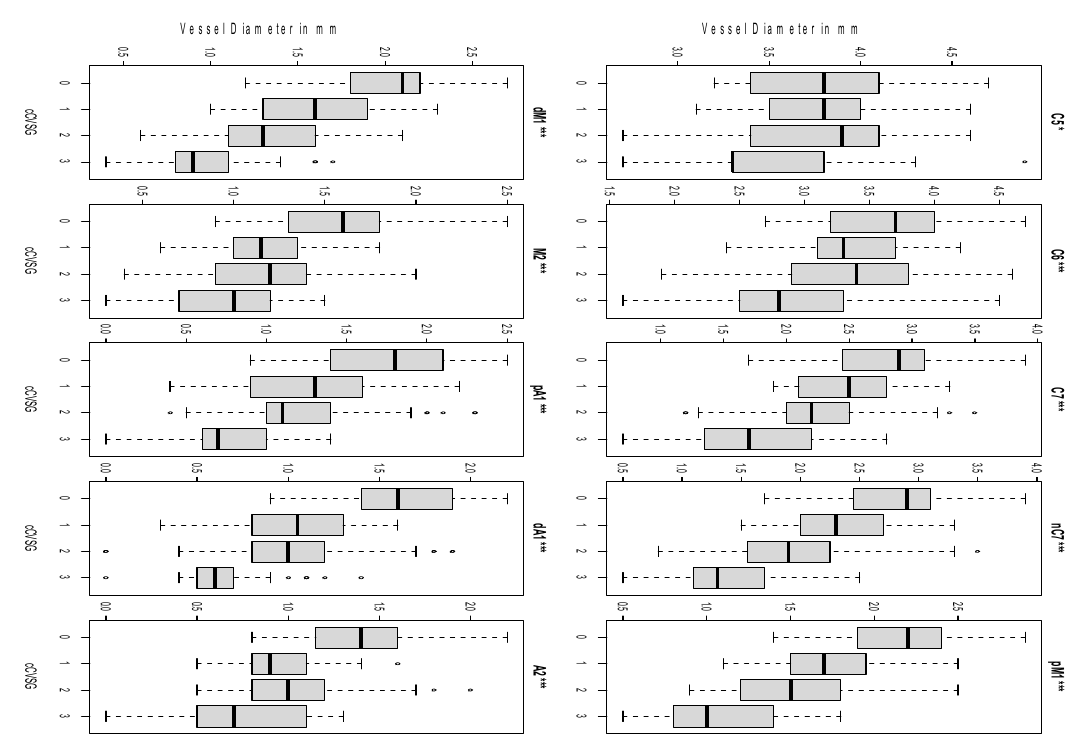
Figure 2. Clustering of vessel diameters. The distribution of vessel diameters according to cCVSG 0–3 after mathematical clustering is shown. All vessel segments had a significant intergrade difference (* C5 p = 0.013, *** the remaining p < 0.001). Discordant values are shown as small circles C5 clinoid segment of the internal carotid artery, C6 ophthalmic segment of the internal carotid artery, C7 terminal segment of the internal carotid artery, nC7 narrowest point of C7, pM1 proximal horizontal segment of the middle cerebral artery, dM1 distal horizontal segment of the middle cerebral artery, M2 insular segment of the middle cerebral artery, pA1 proximal pre-communication segment of the anterior cerebral artery, dA1 distal pre-communication segment of the anterior cerebral artery, A2 post- communicating segment of the anterior cerebral artery. The small circles show the discordant